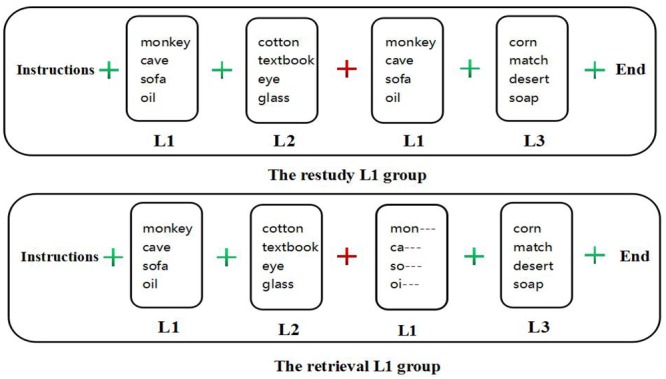
The procedure of Experiment 1.